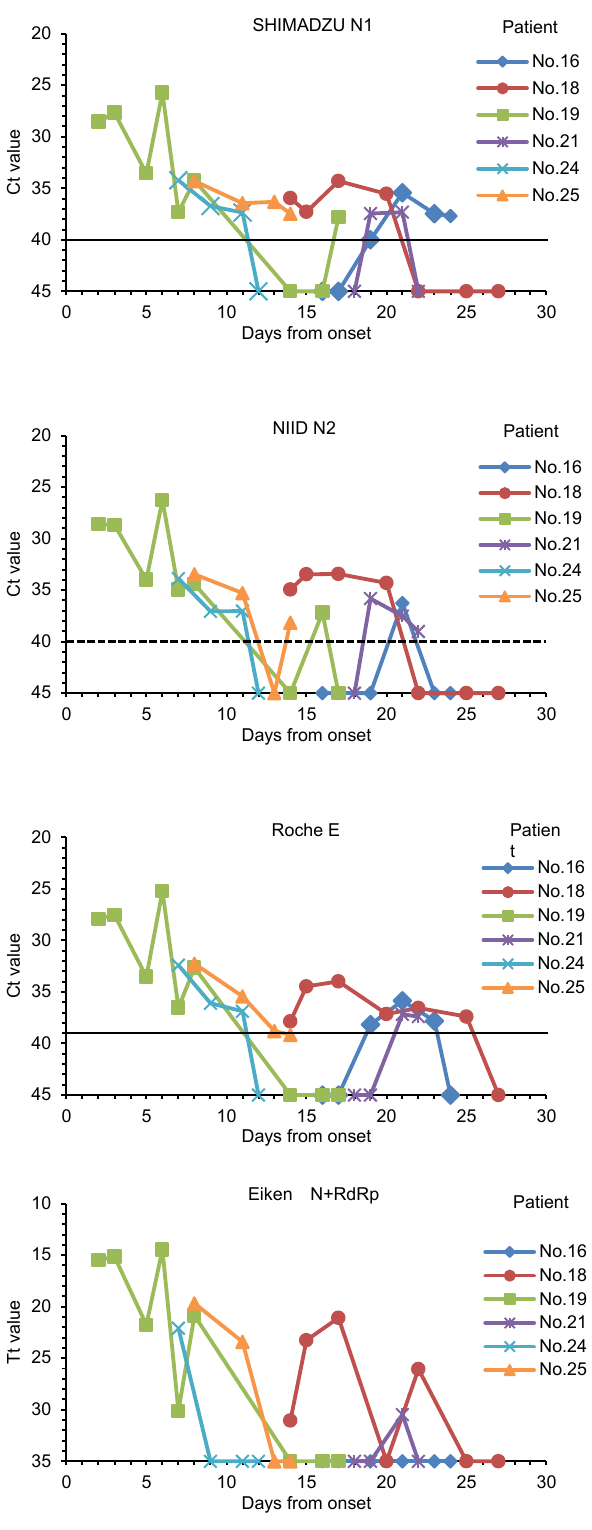
Figure 1: Cycle threshold (Ct) and threshold time (Tt) values detected in nasopharyngeal swabs obtained from patients infected with SARS-CoV-2. Cutoff values are indicated by the dashed lines. Samples for which noincrease inthe amplificationcurve was obtainedare indicatedby the Ct value of 45 and the Tt value of